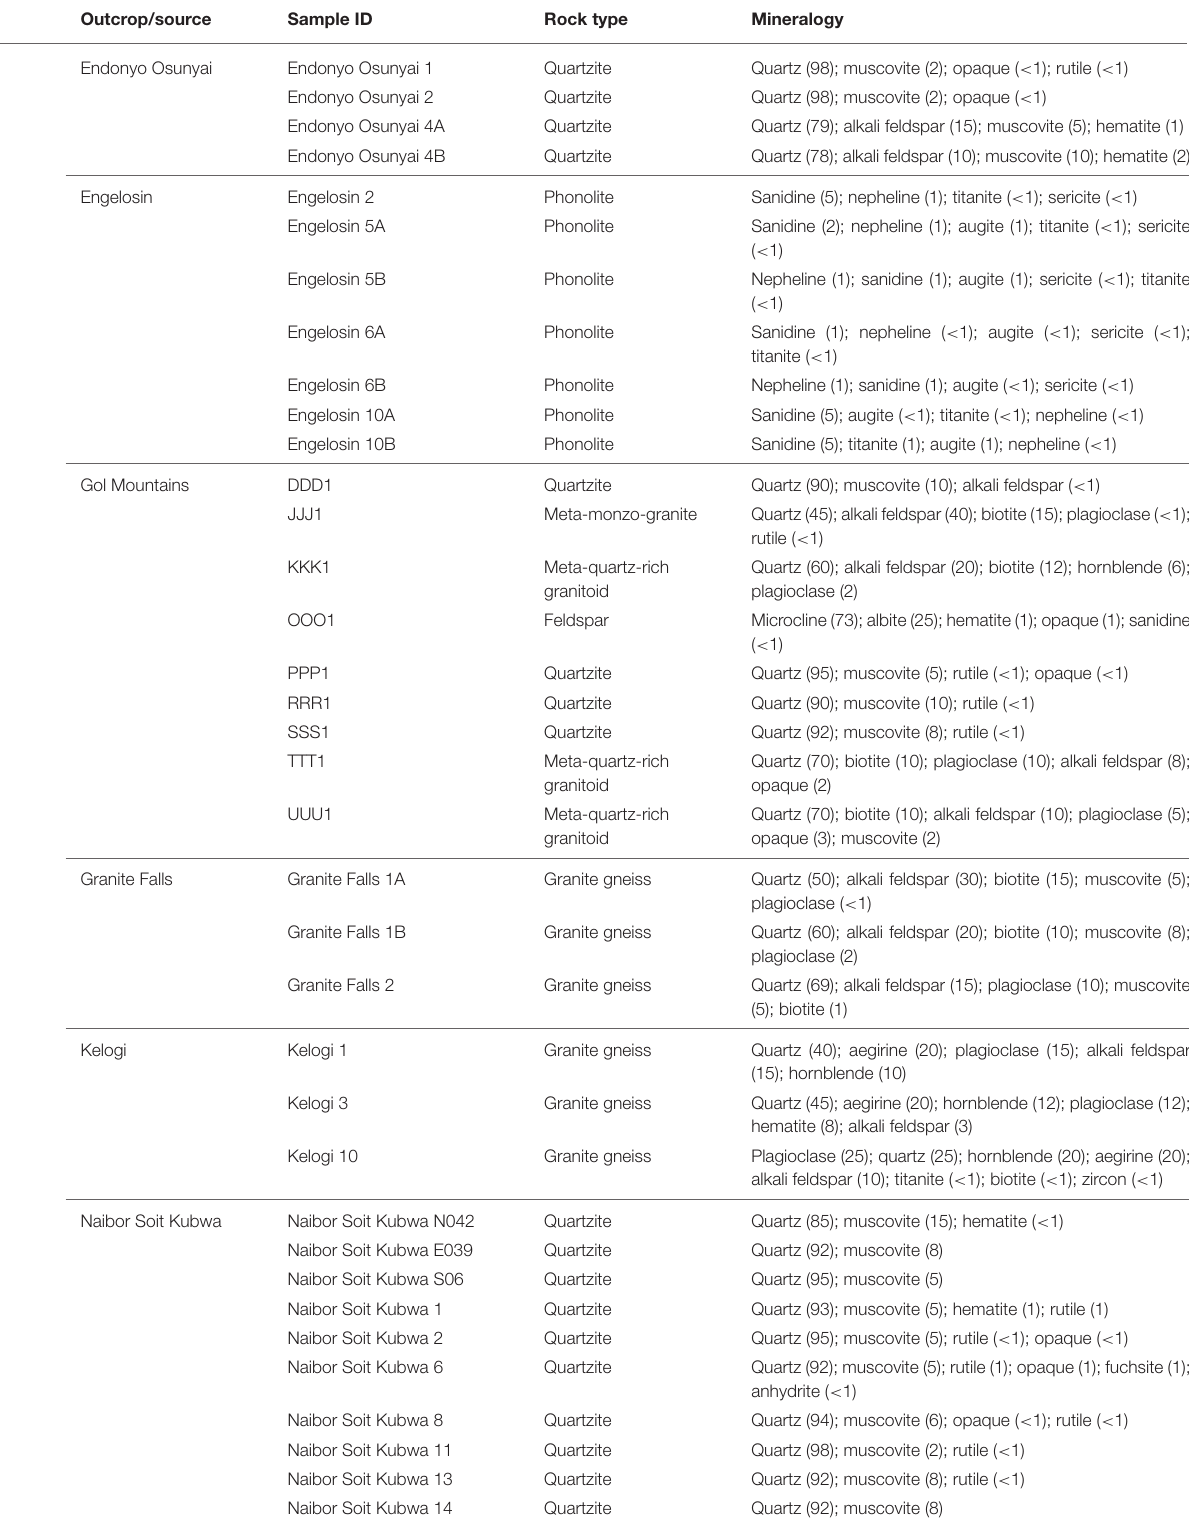
TABLE 2 | Visually estimated modal percentages per